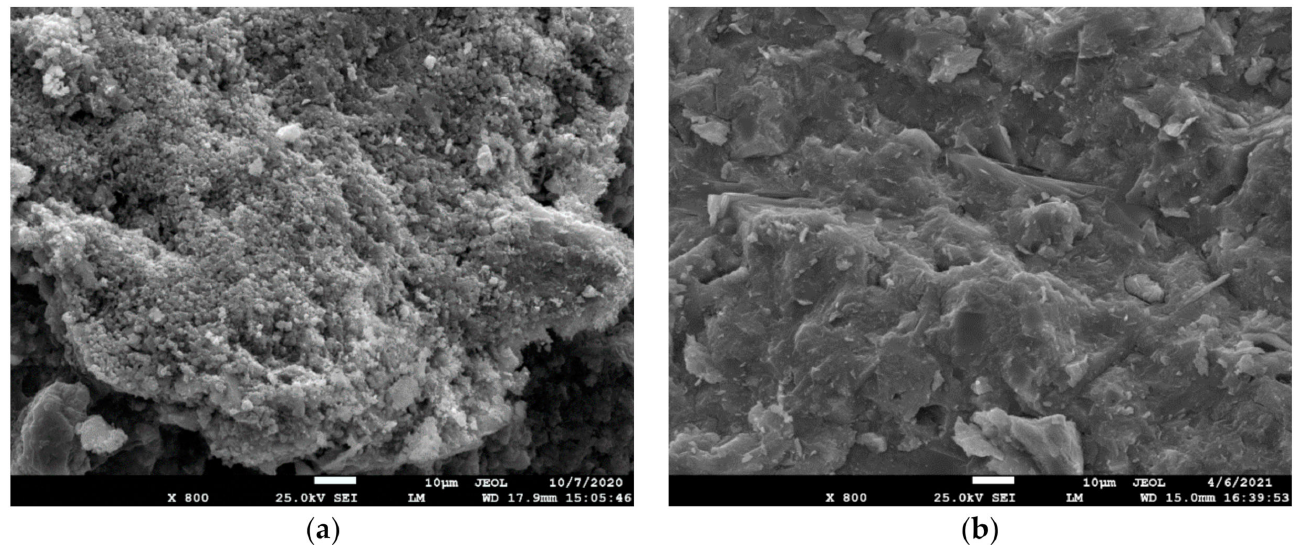
Figure 1. Concrete microstructure: common concrete with water–cement ratio w/c = 0.55 ( a ), and high-performance concrete, variant 1 with w/c = 0.29 ( b ).